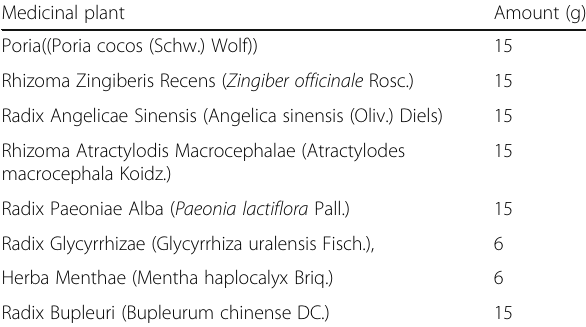
Table 1 Composition of XYS Medicinal plant Amount (g) Poria((Poria cocos (Schw.) Wolf))